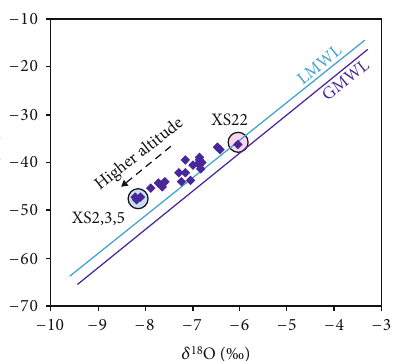
Figure 4: Stable isotopic composition of springs. All springs lie around the LMWL, suggesting limited evaporation during recharge. LMWL for Zunyi: δ 2 H = 7 : 89 δ 18 O + 11 : 95 [46]; GMWL: δ 2 H = 8 δ 18 O + 10